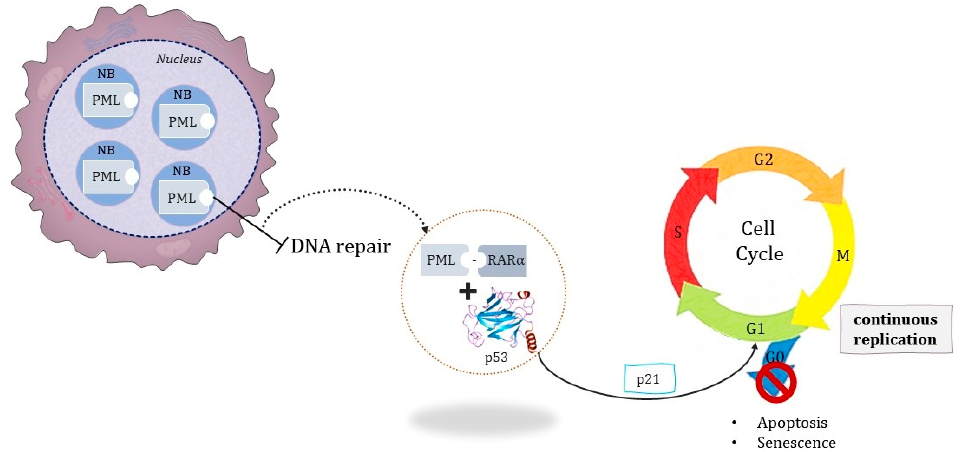
Figure 3. PML-RAR α interaction with p53 interrupting DNA repair and apoptosis. PML proteins are generated in NBs and are related to cell maturation and senescence through the p53 signaling pathway. Therefore, the association of chimeric protein PML-RAR α to p53 protein leads cells to continuously replicate and become non-responsive to cellular signals of senescence and apoptosis.